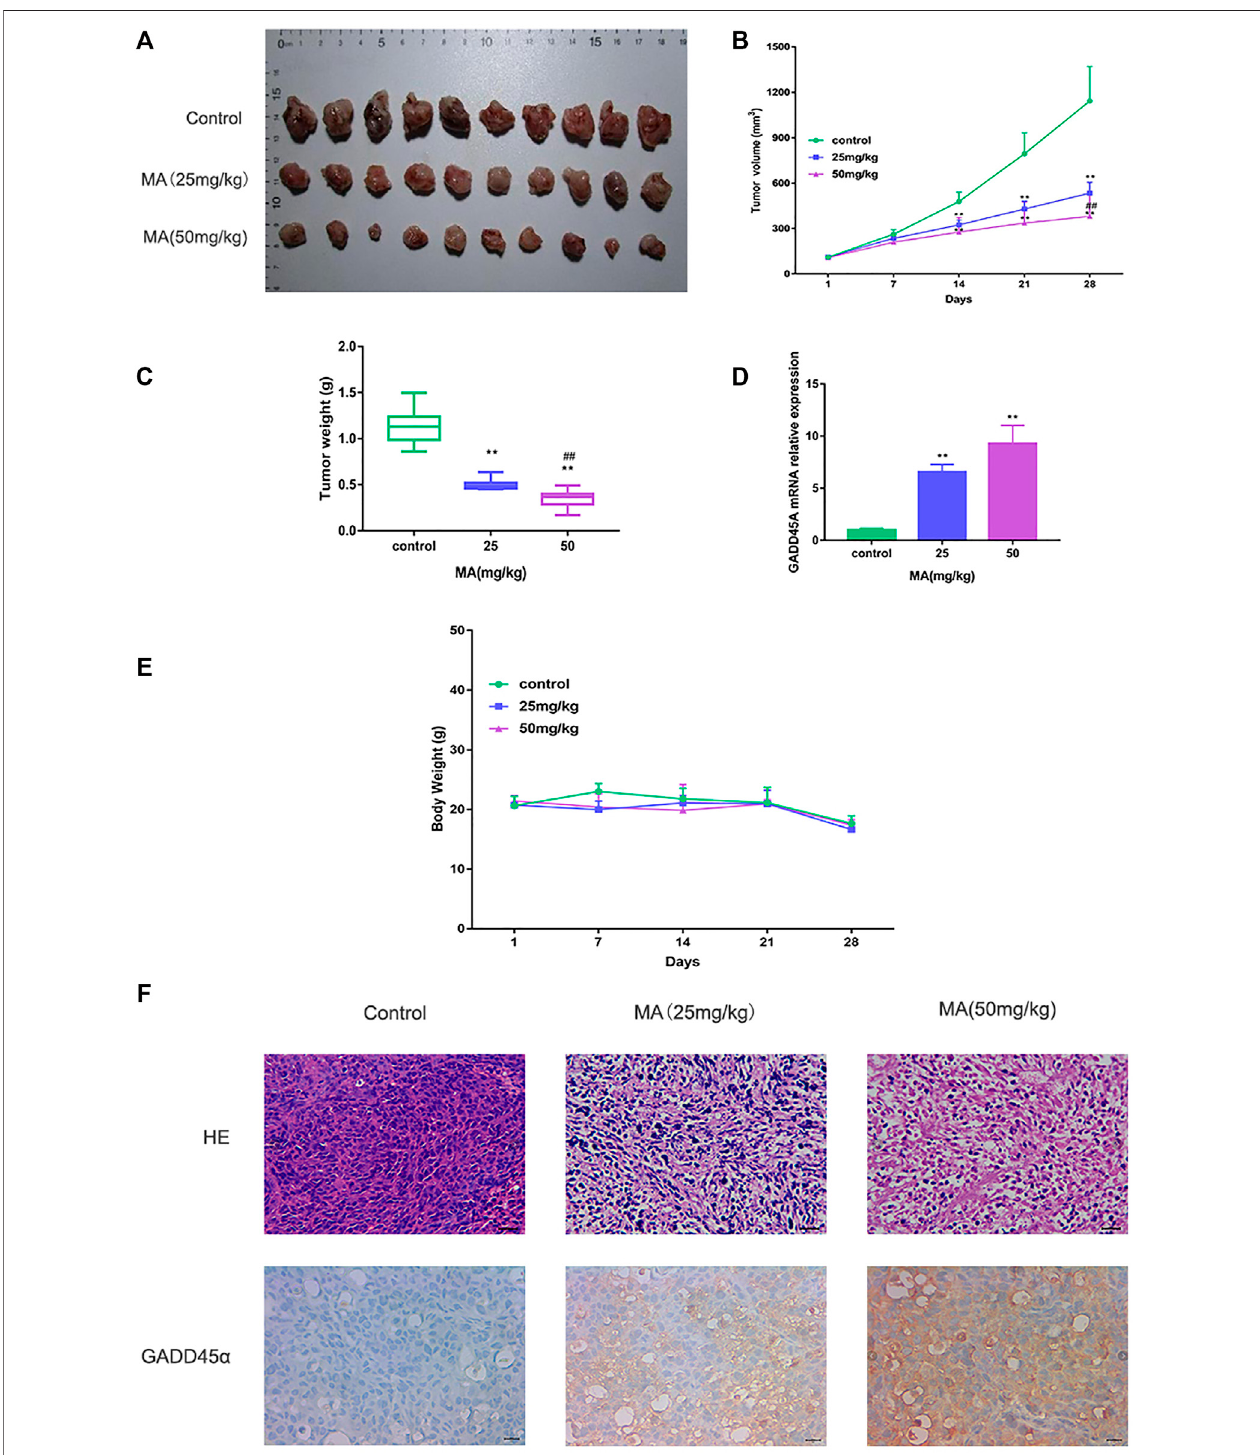
FIGURE 5 | MA restrains TNBC tumor growth. (A) Collected tumor tissues after MA administration. (B) Tumor volumes in different groups during the experiment. (C) Tumor weights in different groups after MA administration. (D) Real-time PCR analysis of GADD45 α mRNA levels in xenograft models at the end point. (E) Body weightsofmice indifferentgroupsduringtheexperiment. (F) RepresentativeimagesofHEstainingandIHCanalysisofGADD45 α afterMAadministration. Compared to the control group, ** p < 0.01; compared to the low-dose group, ## p < 0.01.